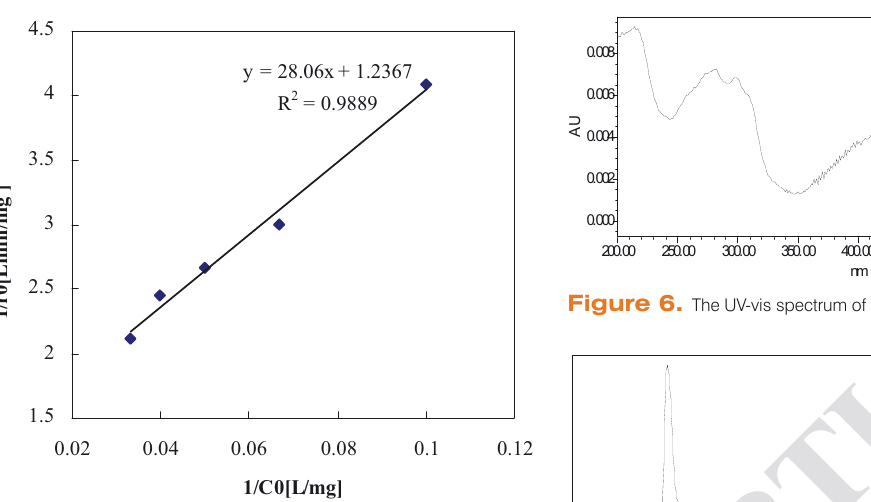
Figure 4. The linear transformation of 1/r